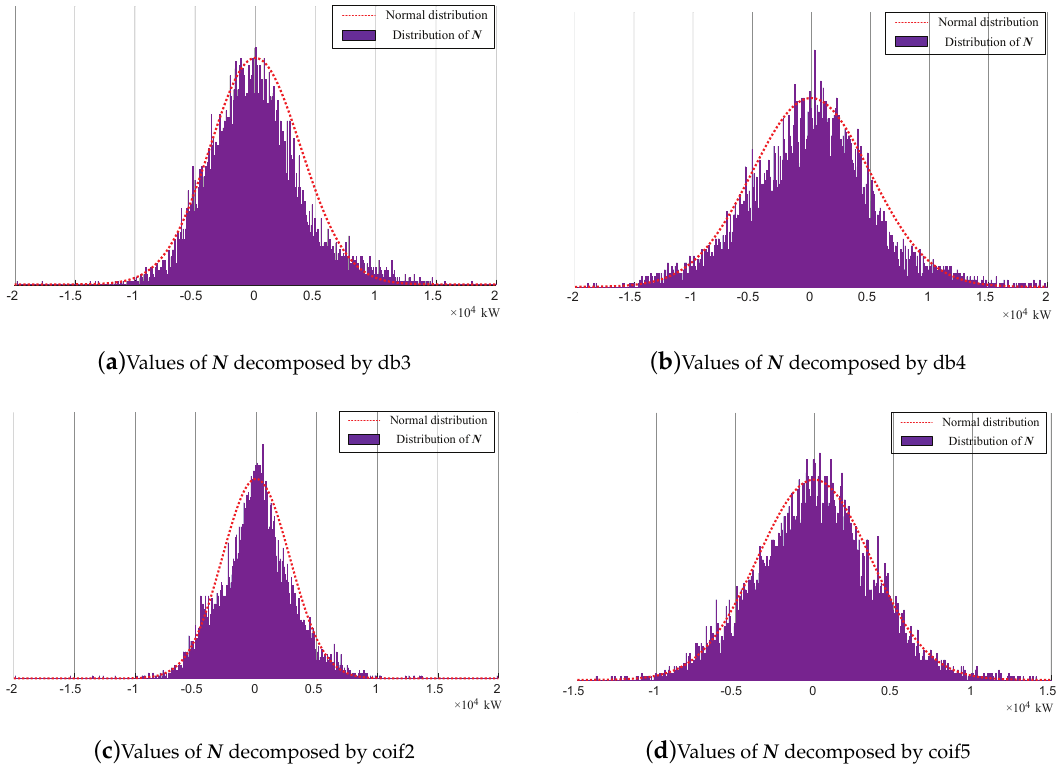
Figure 3. The distributions of N compare to normal